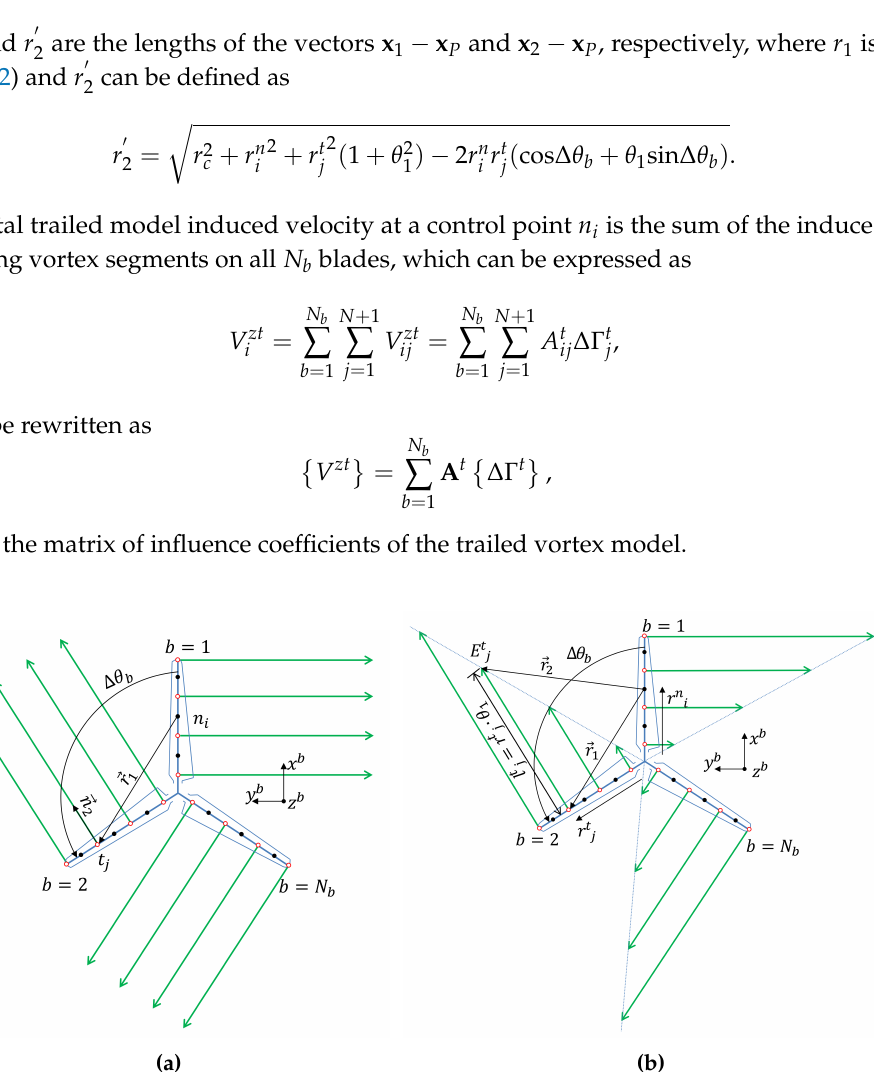
Figure 3. The trailed vortex models: infinite length ( a ); and finite length ( b